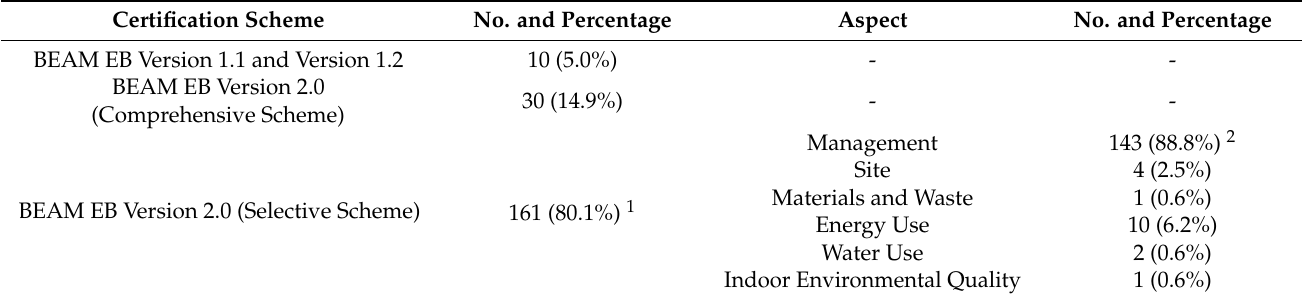
Table 1. Breakdowns of certifications by schemes (N = 201).